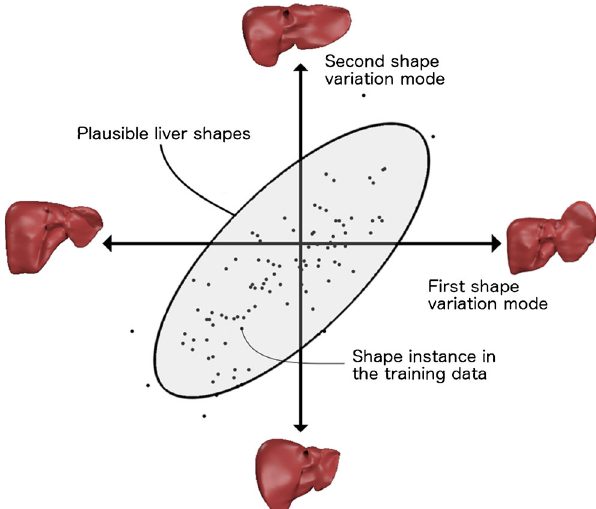
Fig. 12 Statistical shape models. To restrict the segmentation to a set of admissible liver shapes, a shape database is compiled, from which any new liver shape is expressed by a set of parameters called modes of variation. The various modes of variation (roughly 30 modes) are adjusted to fit the liver shape on image features. Statistical shape models impose hard restriction on the segmentation outcome by integrating prior shape. However, training data cannot capture all variations and therefore are sometimes too limiting to accurately model specific livers